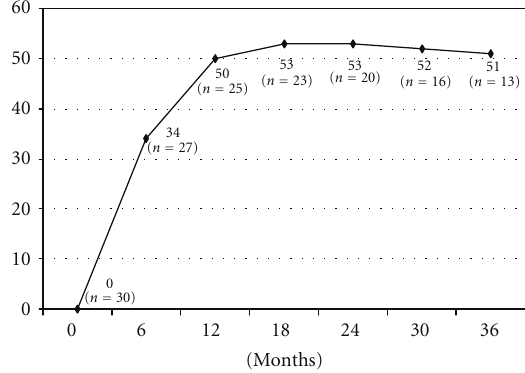
Figure 3: Variation in percentage of excess weight lost (%